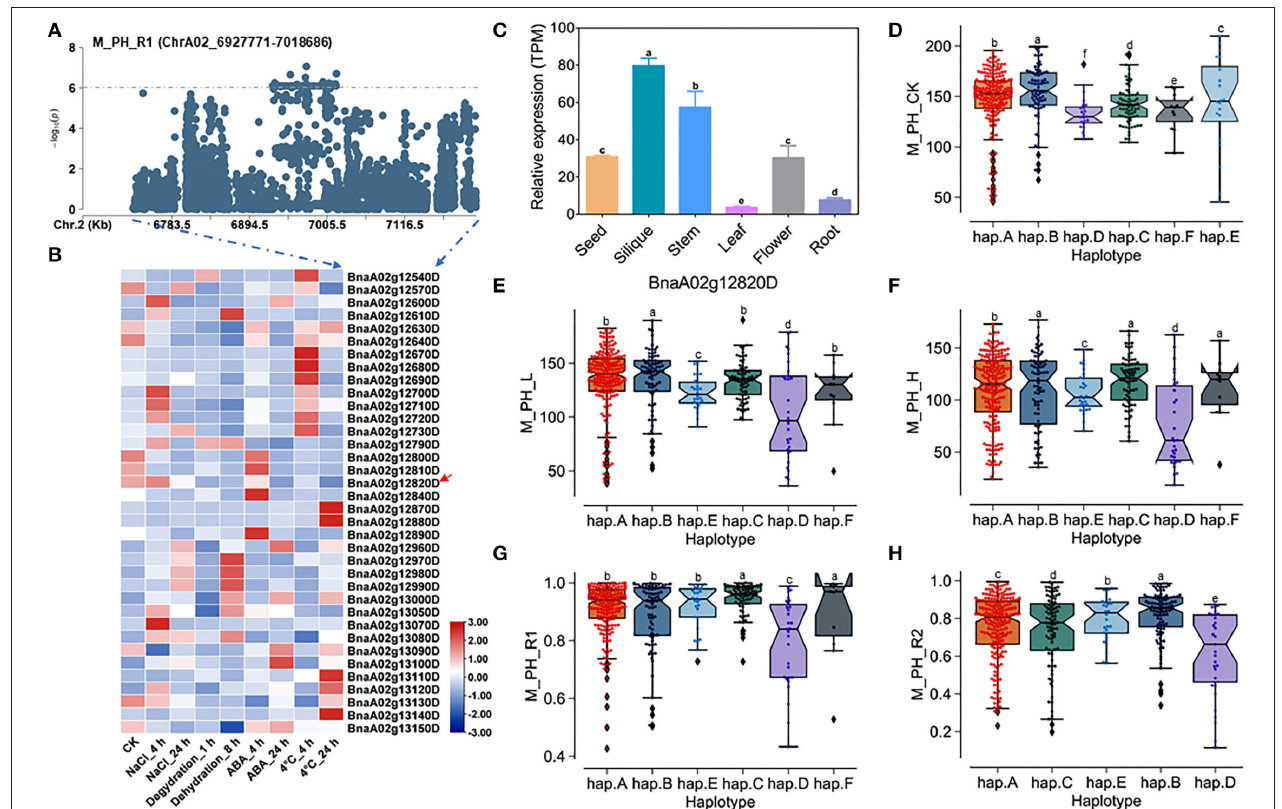
FIGURE 4 | Analysis of candidate genes within the QTL qSAT.A02.1 on ChrA02 associated with M_PH_R1. (A) A zoom-in view of the Manhattan plot on ChrA02 from 6,727,771 to 7,218,686 bp in the QTL qSAT.A02.1 region. These points represented the log-transformed P -values from GWAS for the ratio of plant height between low-salt-alkali and control conditions at the mature stage (M_PH_R1). (B) Gene expression of candidate genes identified within 200kb upstream or downstream of the significantly associated SNPs under 200-mM NaCl, 25- µ M ABA, 4 ◦ C low temperature conditions for 4 and 24h and under the dehydration condition for 1 and 8h in B. napus cultivar Zhong Shuang 11 (“ ZS11 ”). (C) Expression levels of BnA02g12820D in different tissues of B. napus cultivar “ ZS11 .” Values were means ± SD ( n = 3 replicates), and different letters significantly indicate differences at p < 0.05 using two-way ANOVA. (D–F) Boxplots of haplotypes of BnA02g12820D for absolute value of the plant height (M_PH) at the mature stage under control conditions (M_PH_CK, D ), the low-salt-alkali condition (M_PH_L, E ), and under the high salt-alkali condition (M_PH_H, F ). Values were means ± SD ( n = 5 replicates), and different letters indicate significant difference at p < 0.05 using two-way ANOVA. (G,H) Boxplots of haplotypes of BnA02g12820D for relative value of the plant height (M_PH) at the mature stage under the low-salt-alkali condition (M_PH_R1, G ) and under the high-salt-alkali condition (M_PH_R2, H ). Values were means ± SD ( n = 5 replicates), and different letters significantly indicate differences at p < 0.05 using two-way